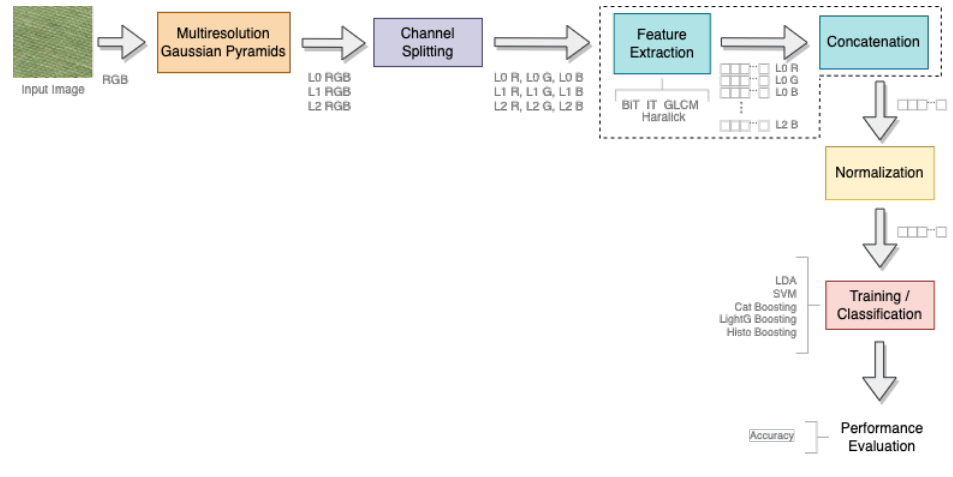
Figure 2. An overview of the proposed